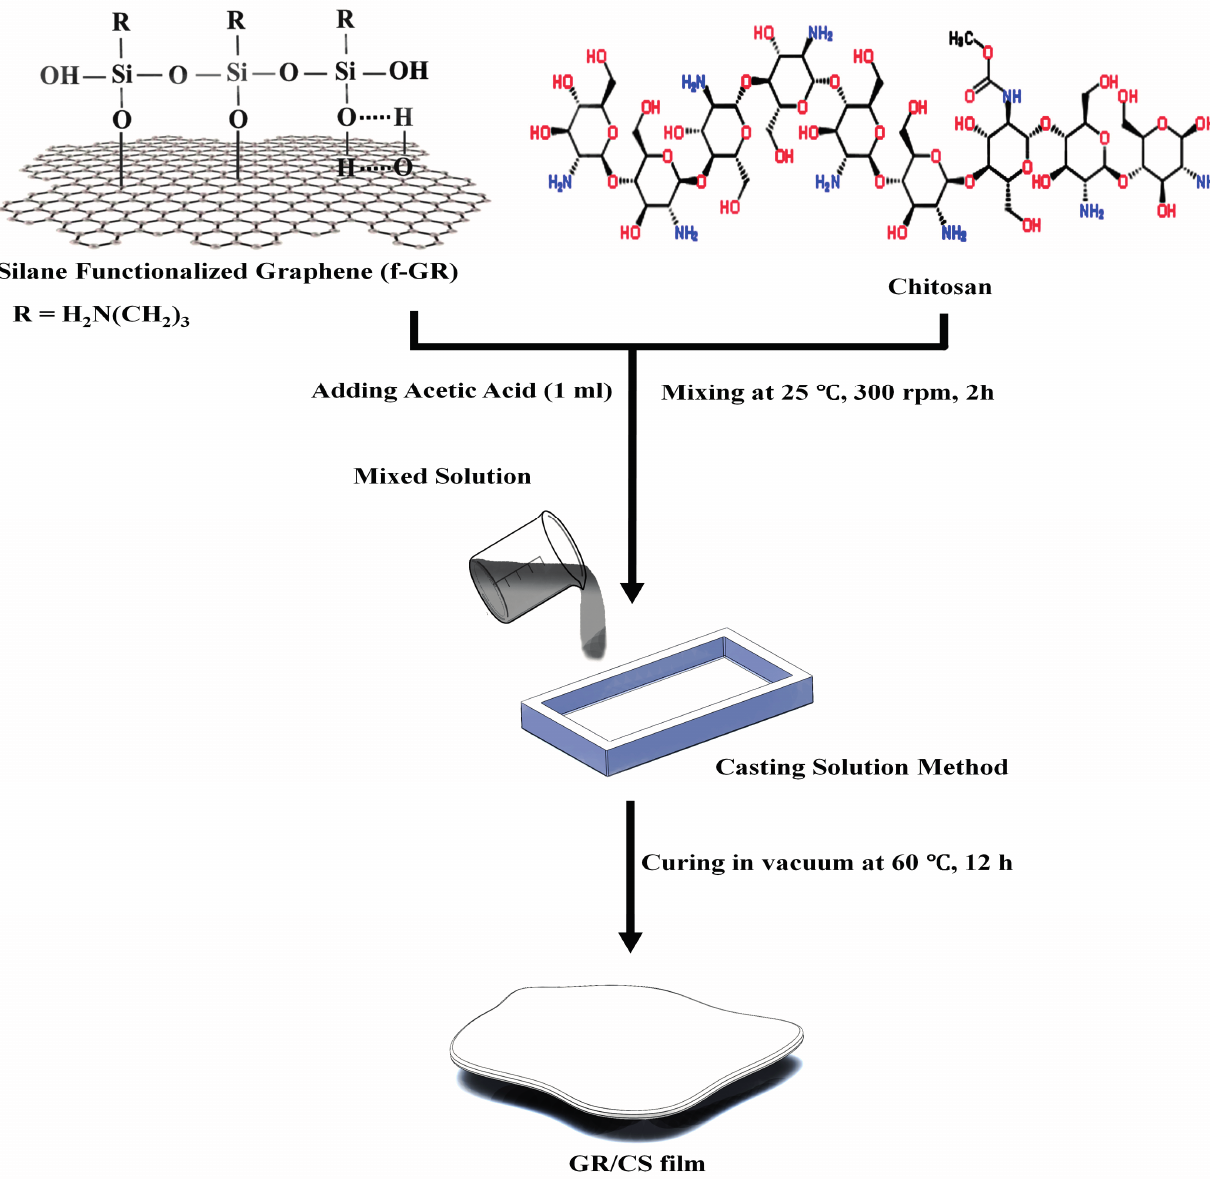
Figure 2. Schematic illustration depicting fabrication process of graphene/chitosan nanocomposite